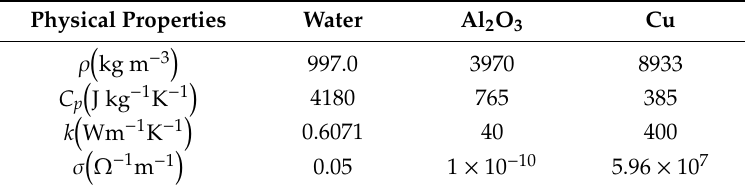
Table 1. Thermophysical properties of hybrid nanofluid